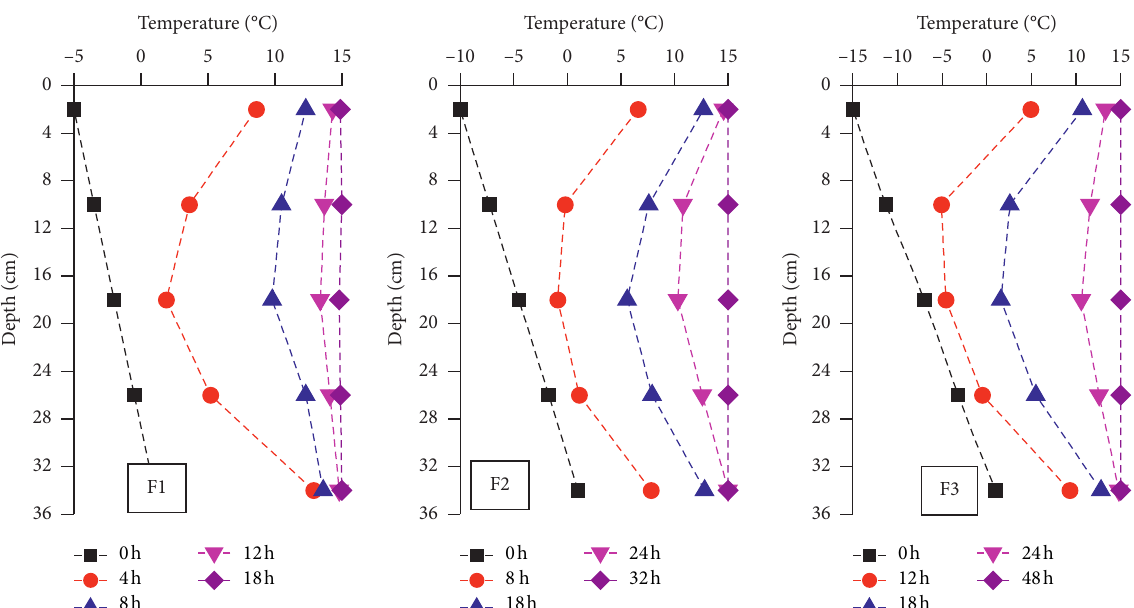
Figure 3: Temperature profiles of the expansive soil columns during the thawing